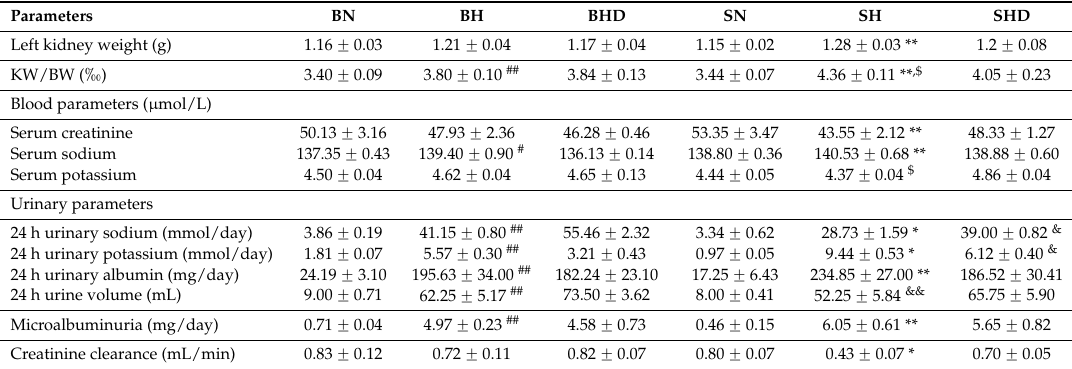
Table 3. Indicators in the serum and urine of SS.13BN and SS rats after